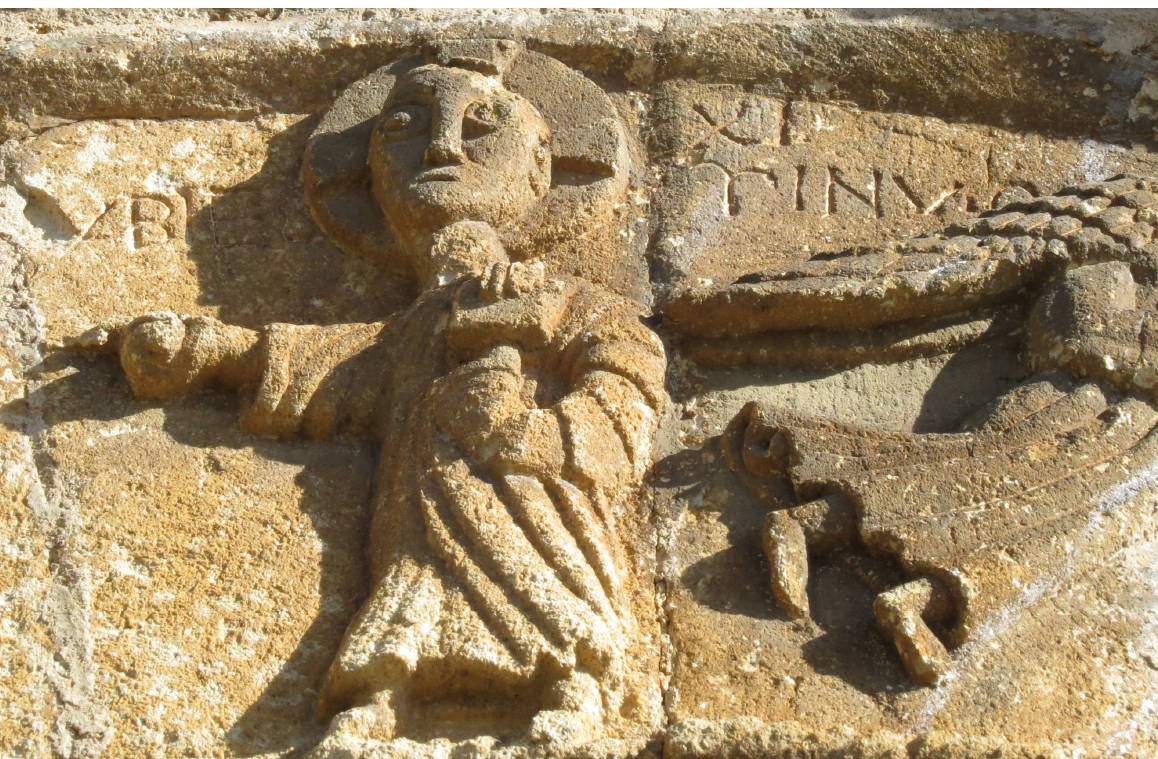
Figure 25. XI RIN[I]US and God as Christ-Logos, detail of archivolt, west façade, 12th c., Saint-Martin Church , Besse, Dordogne, Nouvelle-Aquitaine, France. ©Author.